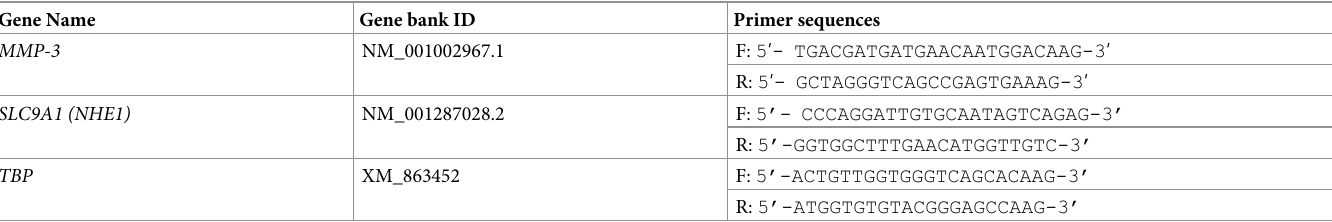
Table 1. Primer sequences for